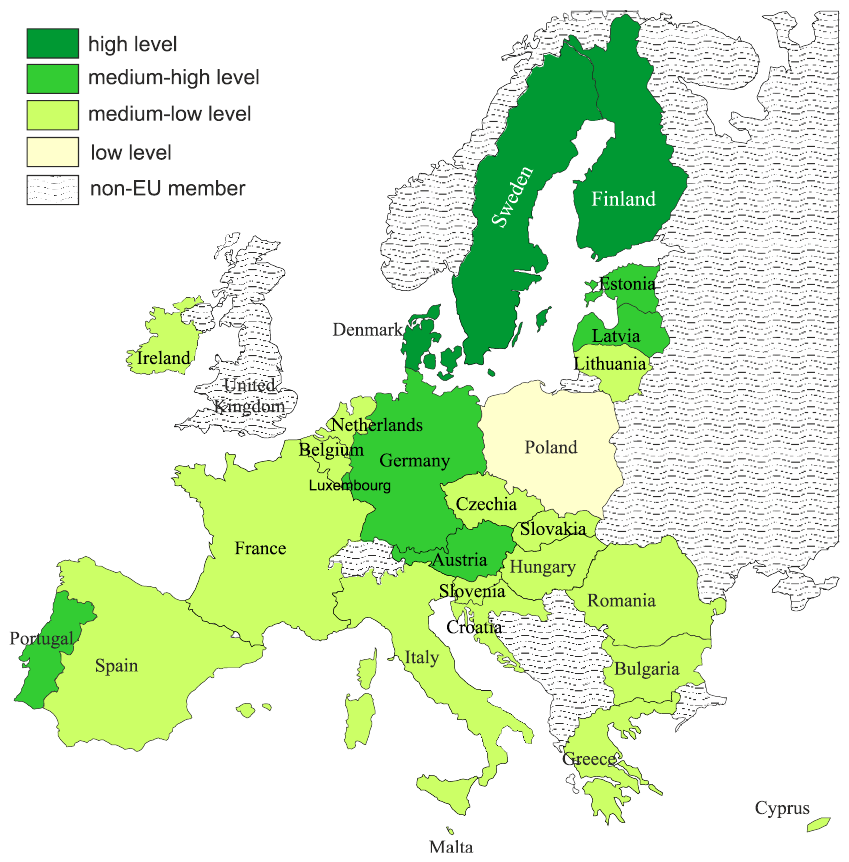
Figure 8. Classification of EU countries in terms of renewable energy use in 2020.